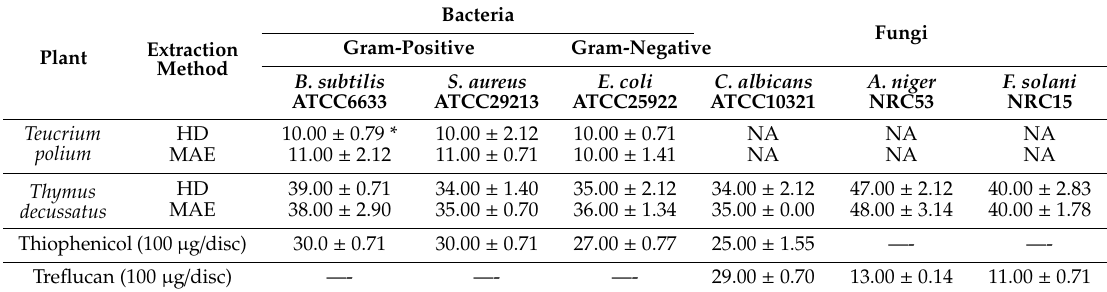
Table 3. Antimicrobial activities of EOs with a concentration of 10 µ L / disc against pathogenic bacteria and fungi.